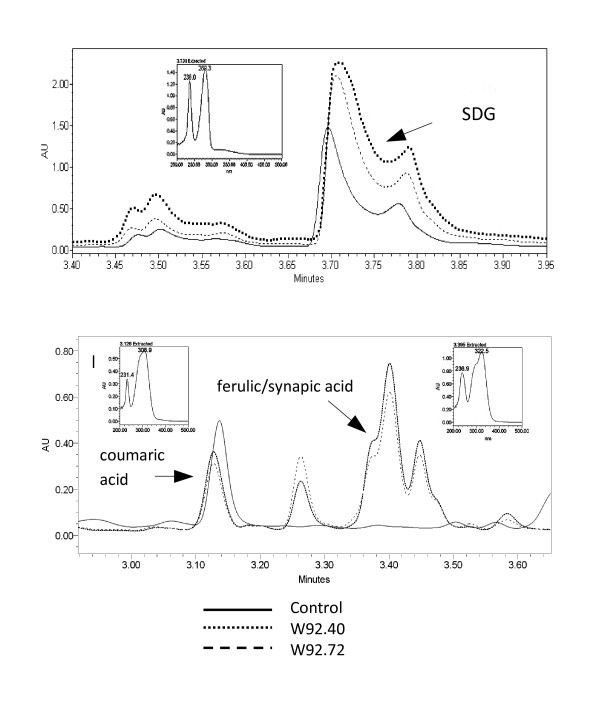
UPLC chromatograms of a crude extracts of flaxseed. A. 280 nm chromatogram - SDG identification, B-320 nm chromatogram- phenolic acids identification; spotted line - transgenic line W92.40, dotted line - transgenic line W92.72,solid line - flax control plants.